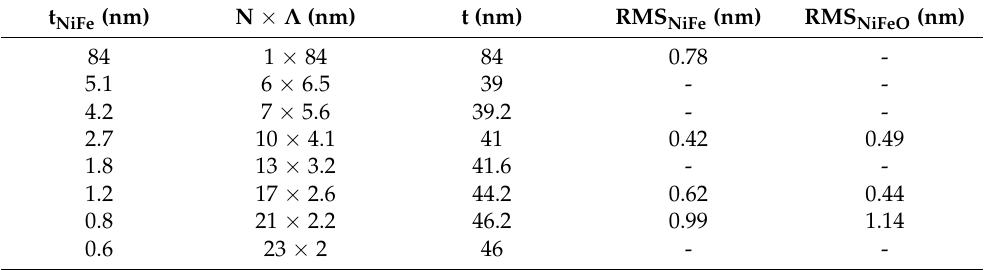
Table 1. Structural details of investigated Ni 0.95 Fe 0.05 /NiFeO multilayers in the as-deposited state. The five columns contain: (i) the thickness t NiFe of the individual NiFe layer in each multilayer period, (ii) the total film thickness t expressed as N × Λ , where N is the number of repetitions and Λ the thickness of one period of the multilayer, (iii) the total film thickness t expressed in nm, (iv) the RMS NiFe is the roughness of the NiFe layers determined by GenX and (v) the RMS NiFeO is the roughness of the oxide layers determined by GenX. The oxide layer t NiFeO is about 1.4 ± 0.2 nm. t NiFe (nm) N × Λ